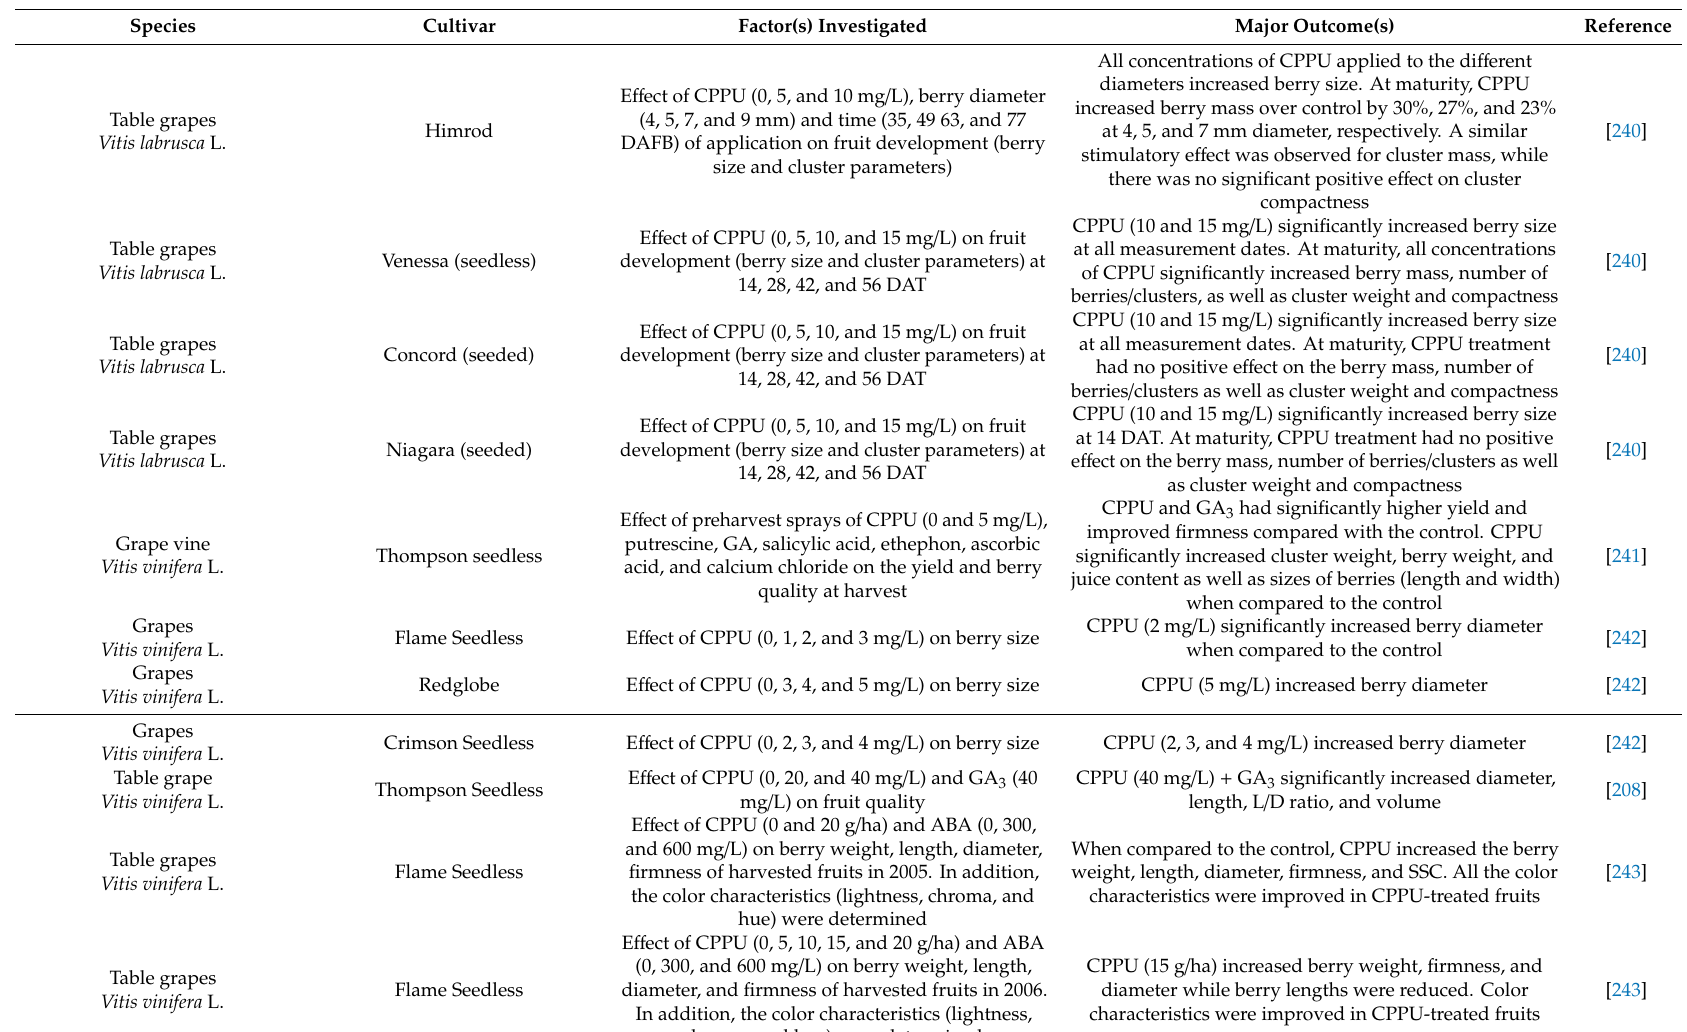
Table grapes Vitis vinifera